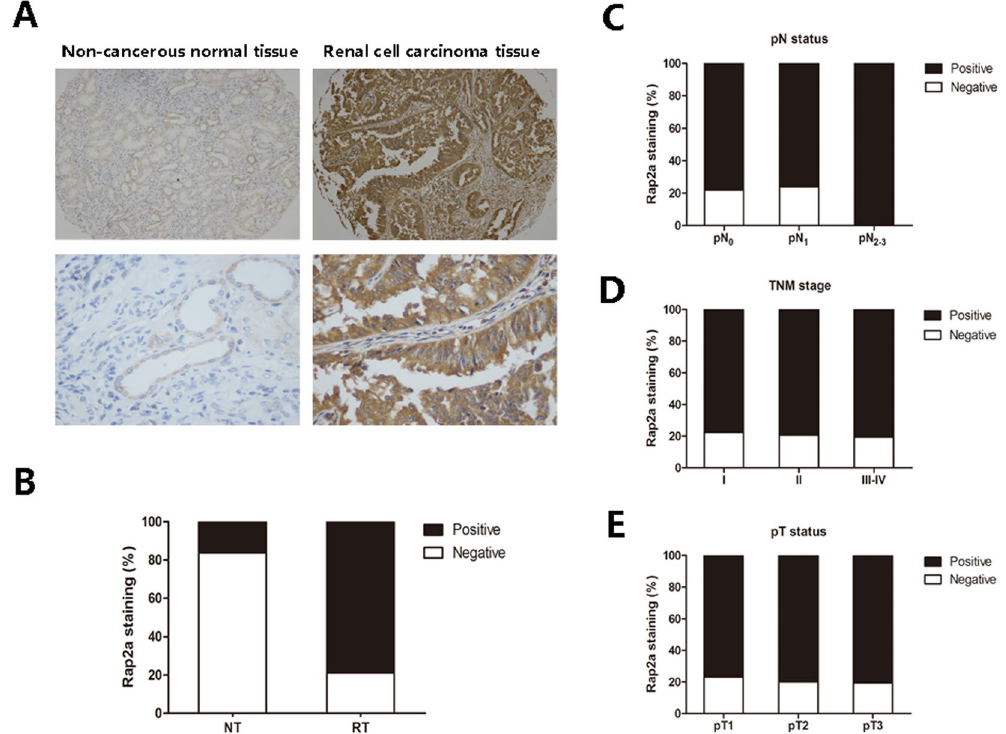
Figure 1. Correlation between Rap2a expression and clinicopathologic parameters in RCC patients. ( A ) Representative photographs showed Rap2a immunohistochemical staining in TMA. They were taken at different magnifications in normal renal tissue and renal carcinoma tissues (Top panel × 100, bottom panel × 400). ( B ) Compared with that in the normal renal tissue, the overall expression level of Rap2a in the renal cell carcinoma tissues was significantly higher ( P < 0.01, χ 2 test). ( C ) Increased Rap2a expression was not correlated with lymphatic metastasis. ( D ) Rap2a expression was not correlated with TNM stage. ( E ) Rap2a expression was not correlated with depth of